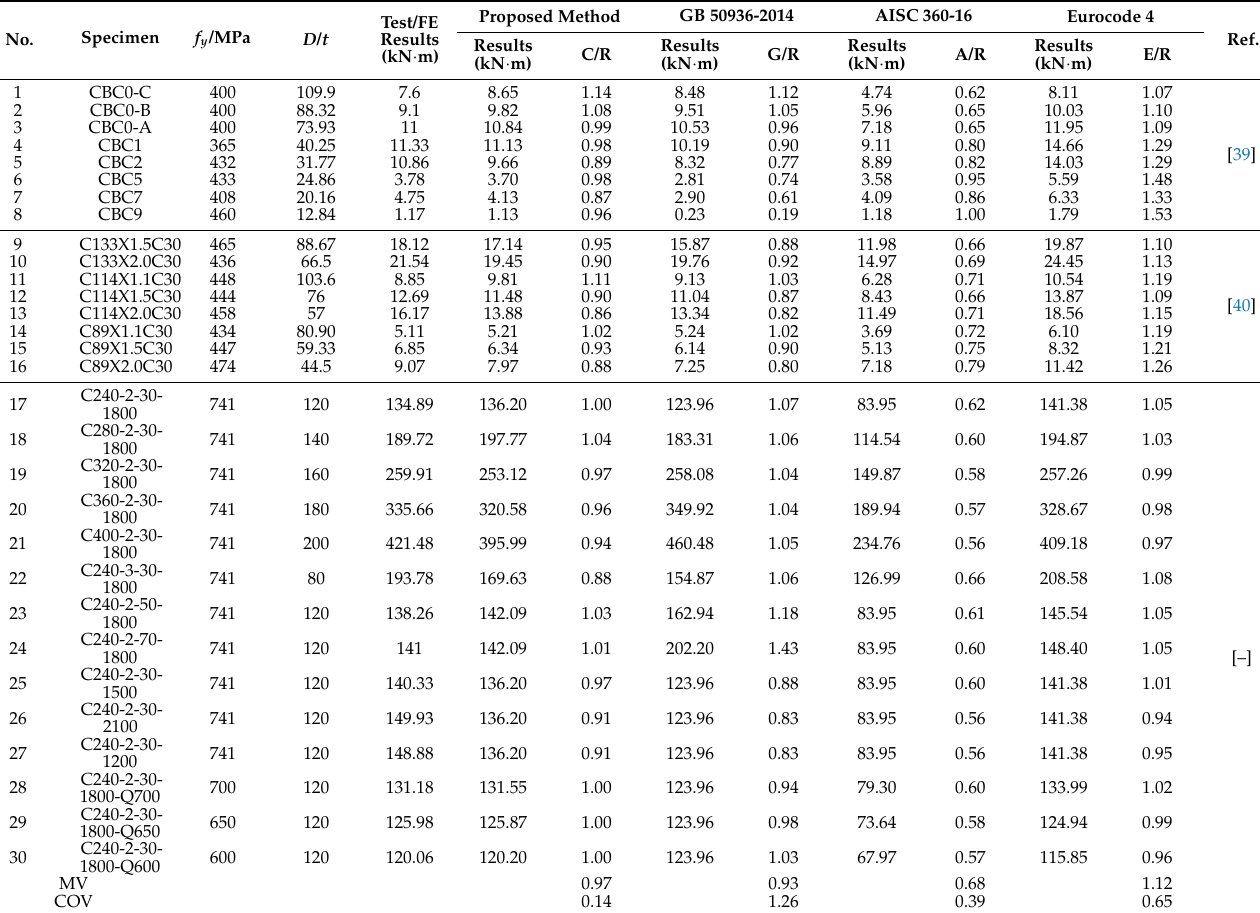
Figure 18. Comparison on prediction results of various methods. ( a ) GB 50936-2014; ( b ) AISC 360-16; ( c ) Eurocode 4. Table 3. Comparison results between the experimental/FE results and design